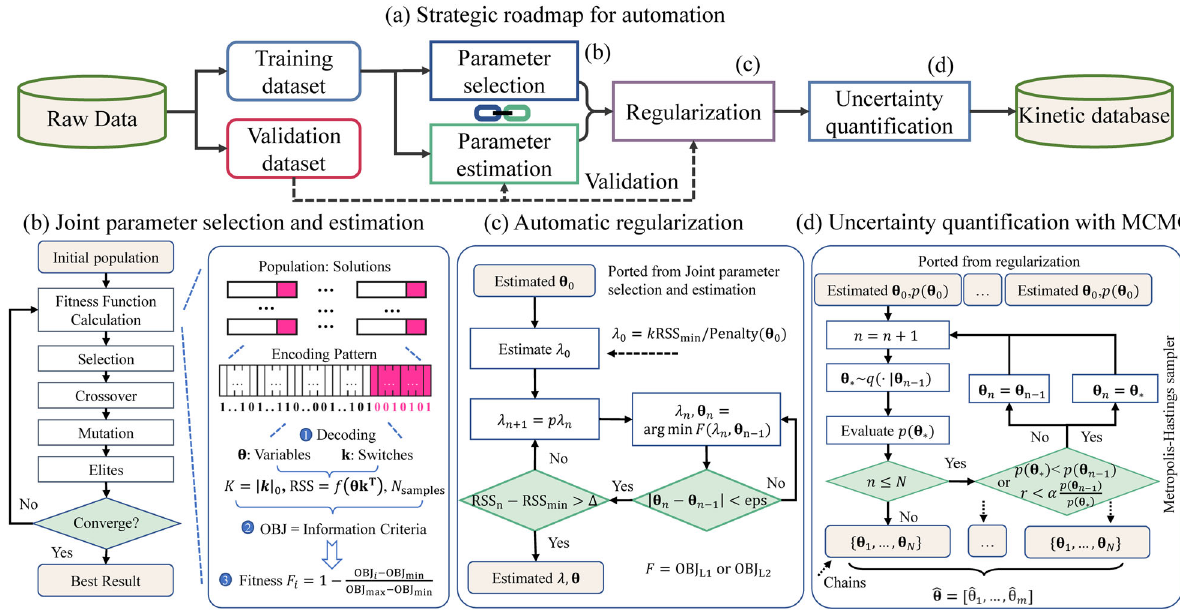
Fig. 1 Development roadmap of the HitDIC software. a Strategic work fl ow for automation; b Schematic illustration of variable-selection genetic algorithm and its encoding pattern of the variables and switches; c Illustration of the regularization algorithm for automatically tuning the regularization term, typical settings of which are k = 1.5 and p = 10 − 3 ; d Illustration of the Metropolis – Hastings algorithm with multiple